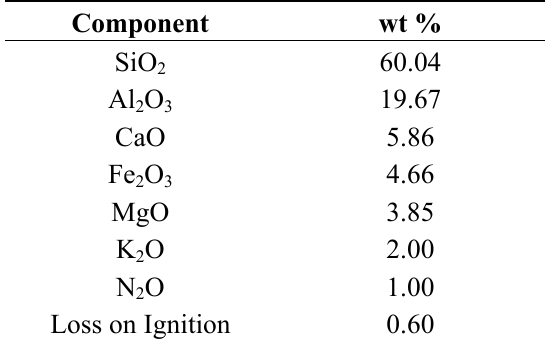
Table 2. Distribution of chemical species on Jim Bridger Power Plant (JBPP) fly ash particles (wt